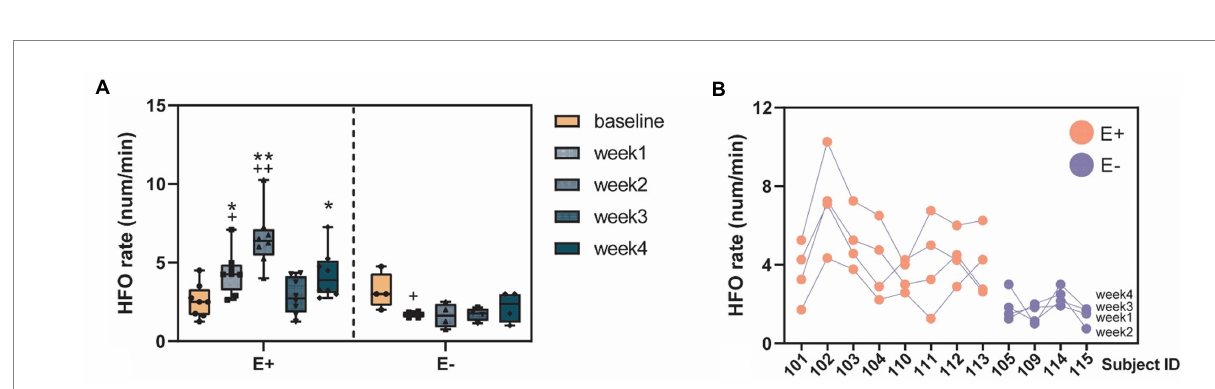
FIGURE 5 High-frequency oscillation (HFO) occurrences before and after KA injection. (A) The HFO rates (num/min) quantified in the E+ animals (n = 9) that showed clear epileptic events (IEDs or seizure) and the E– animals ( n = 4) that did not show any signs of epileptiform events after the KA injection. The E + animals had an increase of HFO rates in the week1–4 post-KA period, compared to the baseline while the E– animals showed no or a small decrease of the HFO rates (week1 vs. baseline, p = 0.43). The E + animals also showed much larger HFO rates in week1, 2, and 4, compared to the E– group. (B) Stability of the individuals weekly HFO rates. Each blob represents the HFO rate in 1 week. Colors indicate the animal group: red = E + and blue = E –. * p < 0.05; ** p < 0.001 between group comparison: E + vs. E –; + p < 0.05; ++ p < 0.001 within group comparison: baseline vs. week